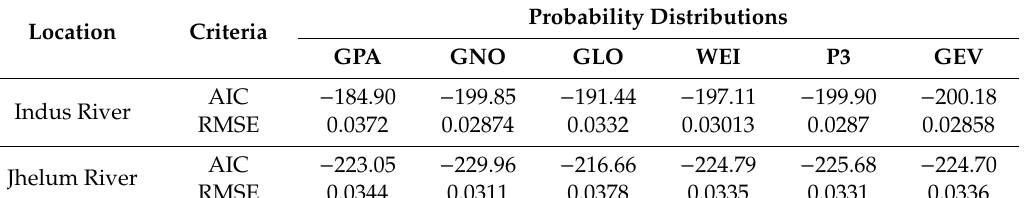
Table 3. Akaike information criteria ( AIC) and root mean square error (RMSE) values of statistical distributions. Akaike information criteria (AIC) and root mean square error (RMSE) values of statistical distributions.